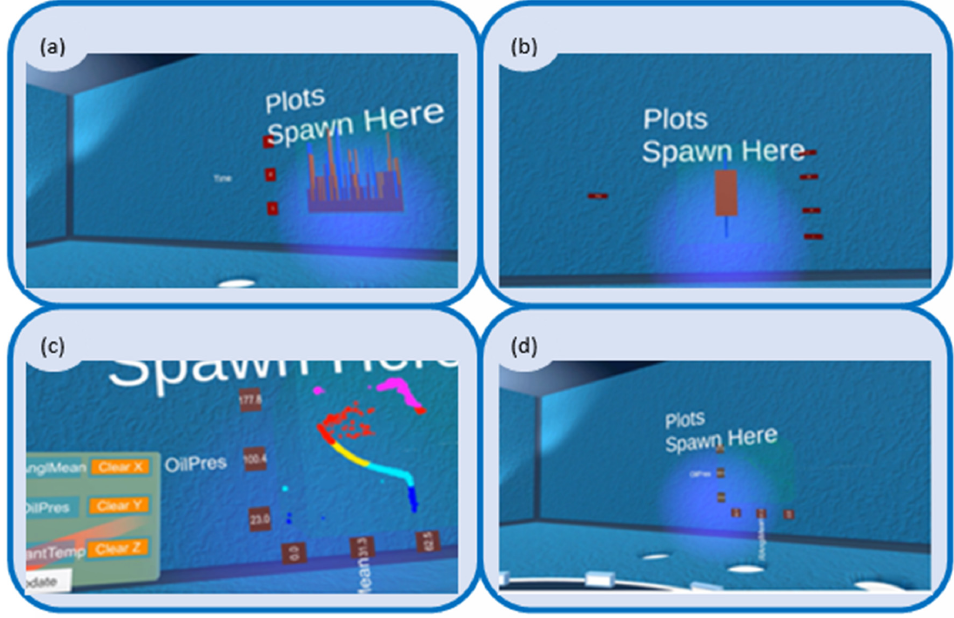
Figure 9. Visualizations supported by IVEE. ( a ) Histogram. ( b ) Box ‐ plot. ( c ) Scatterplot. ( d ) Line plot.